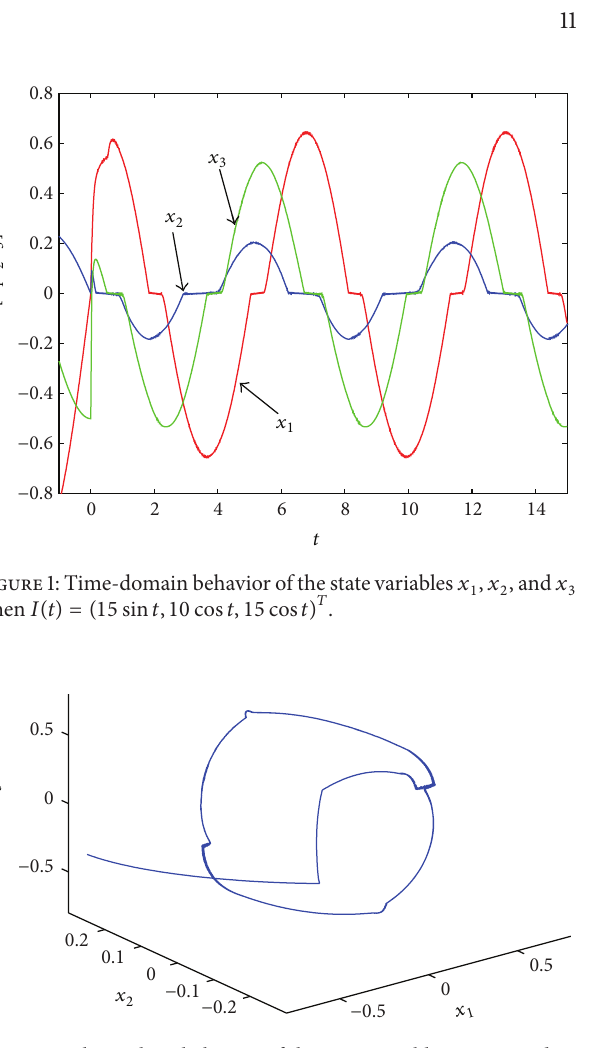
Figure 2: Phase plane behavior of the state variables 𝑥 1 , 𝑥 2 , and 𝑥 3 when 𝐼(𝑡) = (15 sin 𝑡,10 cos 𝑡,15 cos 𝑡) 𝑇